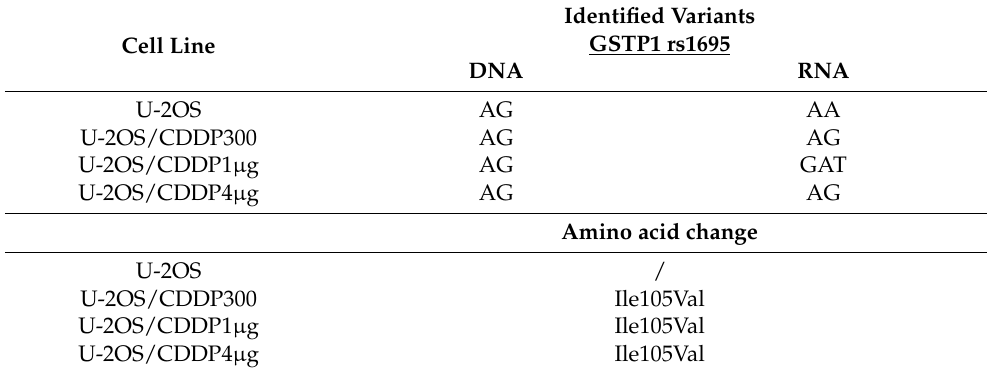
Table 4. RNA single nucleotide polymorphism (SNP) of GSTP1 gene detected in U-2OS cisplatin (CDDP)-resistant variants compared to their parental cell